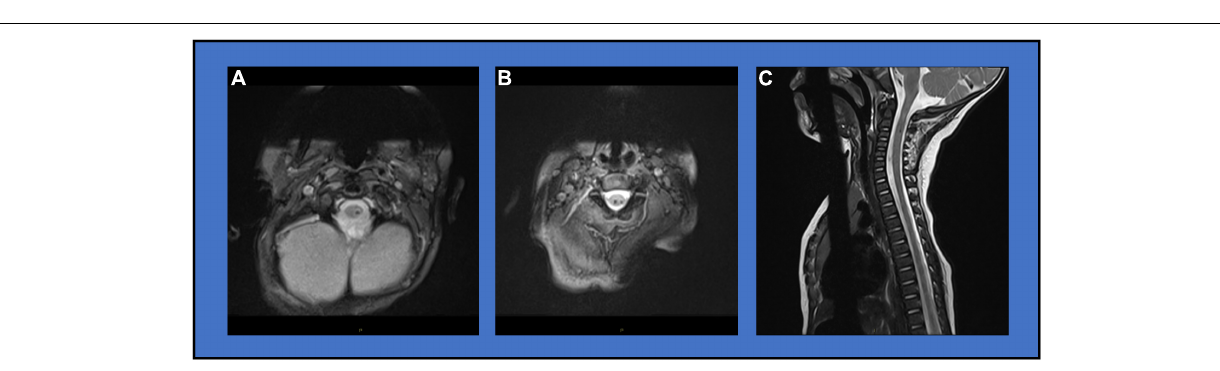
FIGURE 2 | Diagnostic Imaging. (A) MRI Axial MEDIC image showing focal T2 hypointense signal at the C1 level. (B) MRI Axial MEDIC image showing focal T2 hypointense signal at the C2/3 level. (C) MRI Sagittal T2 image showing mixed hypo- and hyper-intensity lesion with volume loss at the C1/2